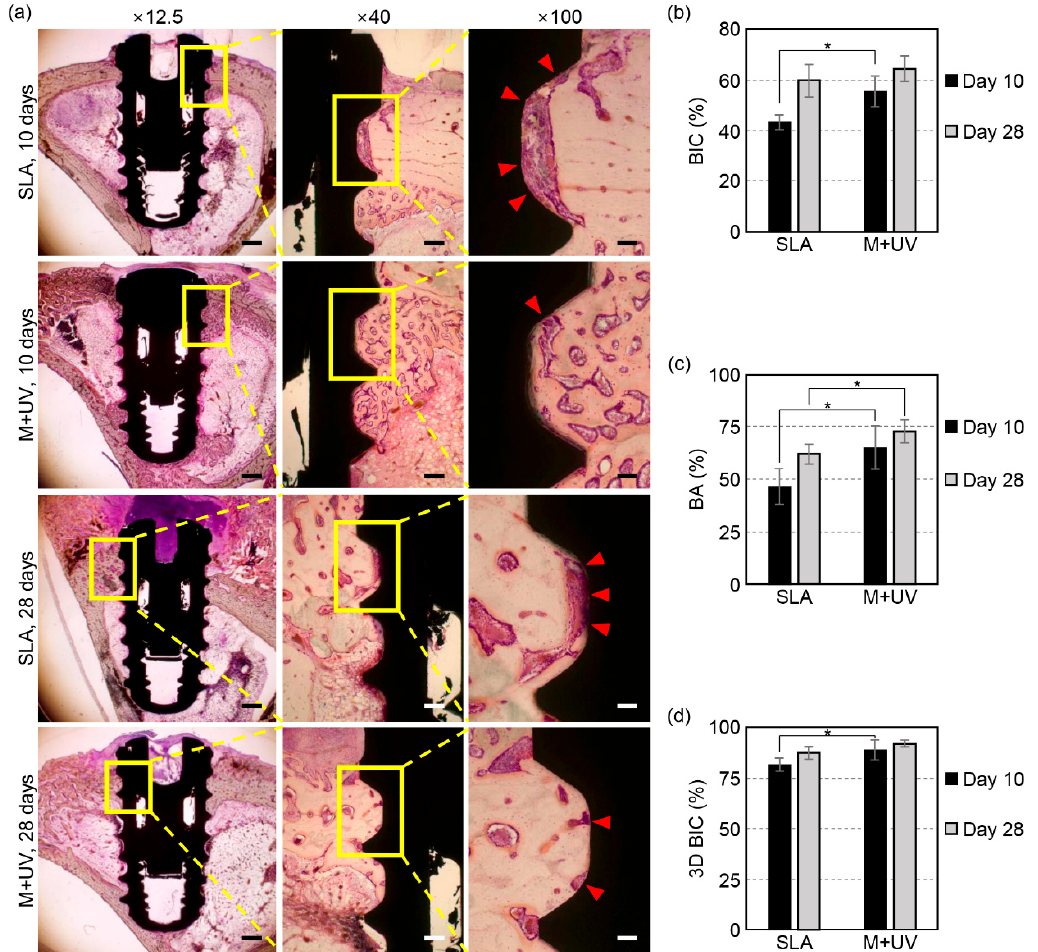
Figure 5. ( a ) Representative histologic sections of the rabbit tibia at 10 and 28 days after the implant placement. In the SLA implant, the osteoblast and organic matrix, which had not mineralized yet, was more observable on the interface between the bone and implant compared to the M + UV implant (red arrow head; magnification × 12.5, × 40, and × 100 from the left, hematoxylin and eosin staining). The scale bars: 1 mm at × 12.5, 200 µ m at × 40, and 100 µ m at × 100 magnification. ( b ) The bone-to-implant contact ratio (BIC) was evaluated histologically at days 10 and 28. The M + UV implant shows a significantly higher BIC than the SLA at day 10, but there is no significant di ff erence at day 28. ( c ) The bone area ratio (BA) evaluated histologically at 10 and 28 days. The M + UV implants show significantly more BA than the SLA at days 10 and 28. ( d ) The bone-to-implant contact ratio evaluated by micro-CT (3D BIC) at days 10 and 28. The M + UV implants show a significantly higher 3D BIC than the SLA at day 10, but there is no significant di ff erence at day 28. Error bars show the standard deviation. (*) represents the significance compared with each pair, p < 0.05.